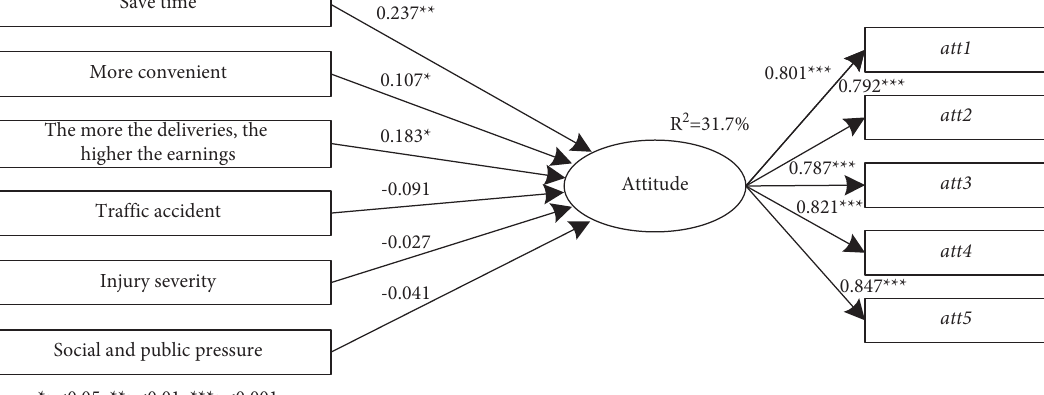
Figure 2: Behavioral beliefs predicting attitude.